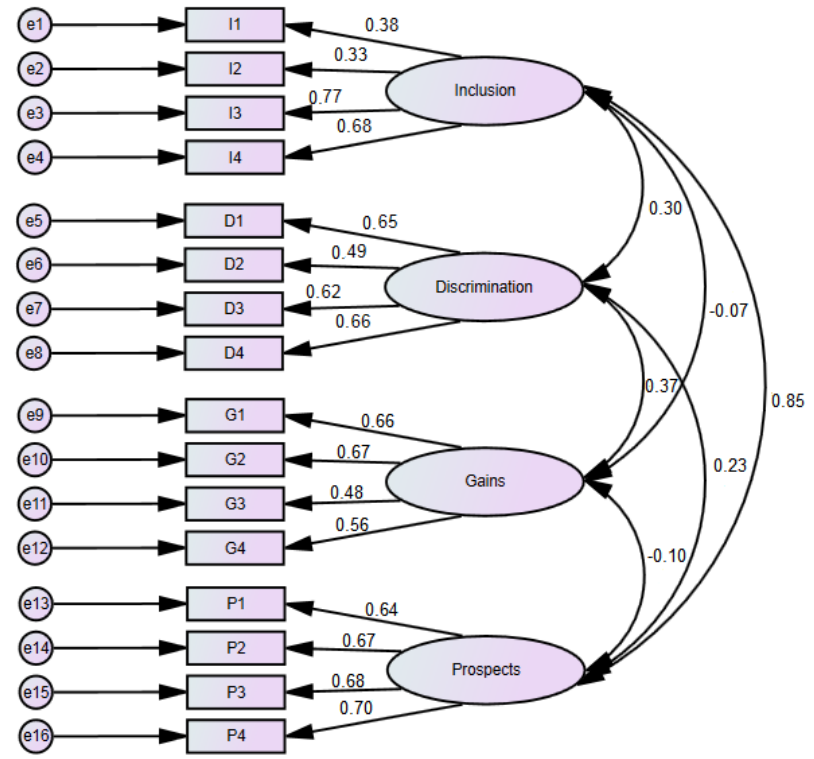
Figure 1. Confirmatory factor analysis model—standardized estimates.